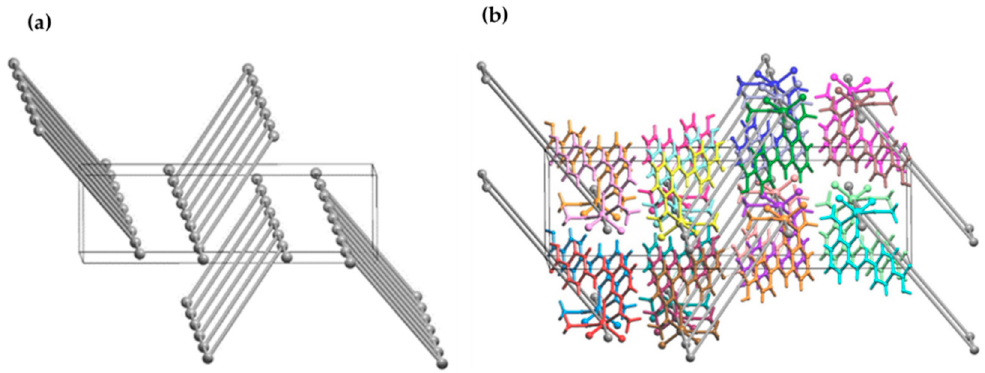
Figure 3. ( a ) Underlying net for the complex 1 crystal structure in standard representation of the H-bonded molecular MOFs and ( b ) Underlying net and fragment of crystal structure for complex 1.